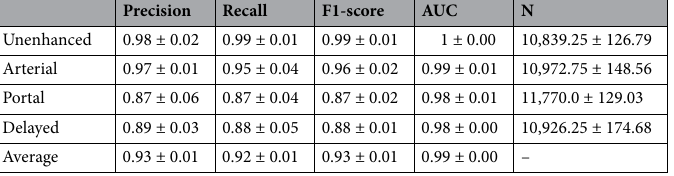
Table 5. Performance metrics in the testing set for the slices evaluation using cross validation. The values are mean±standard deviation.